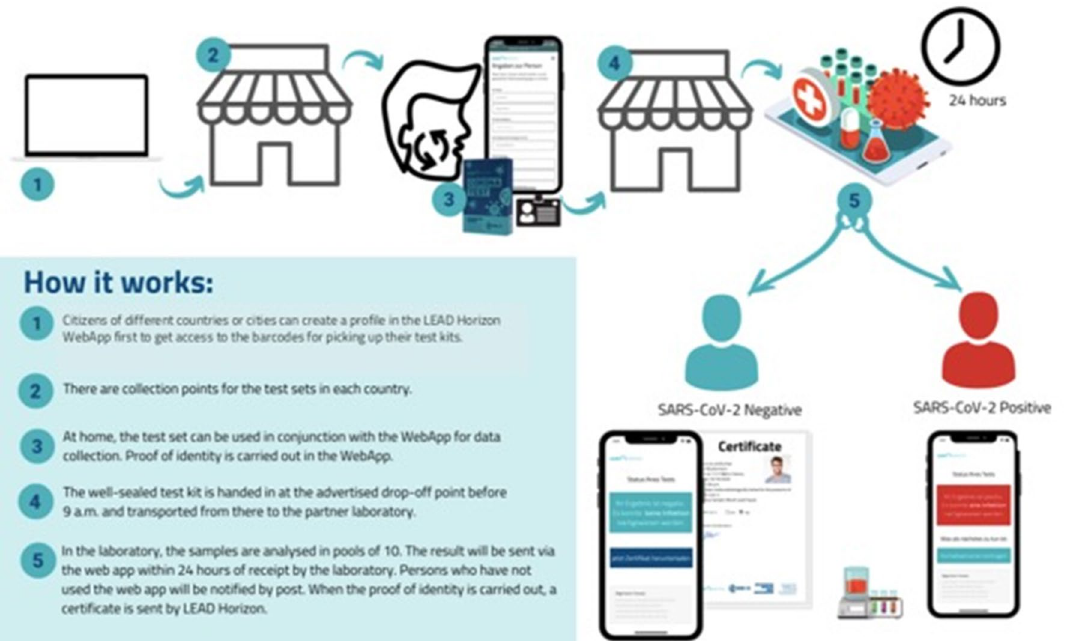
Figure 2. Population-wide testing logistics. An example of the decentralized test strategy used in